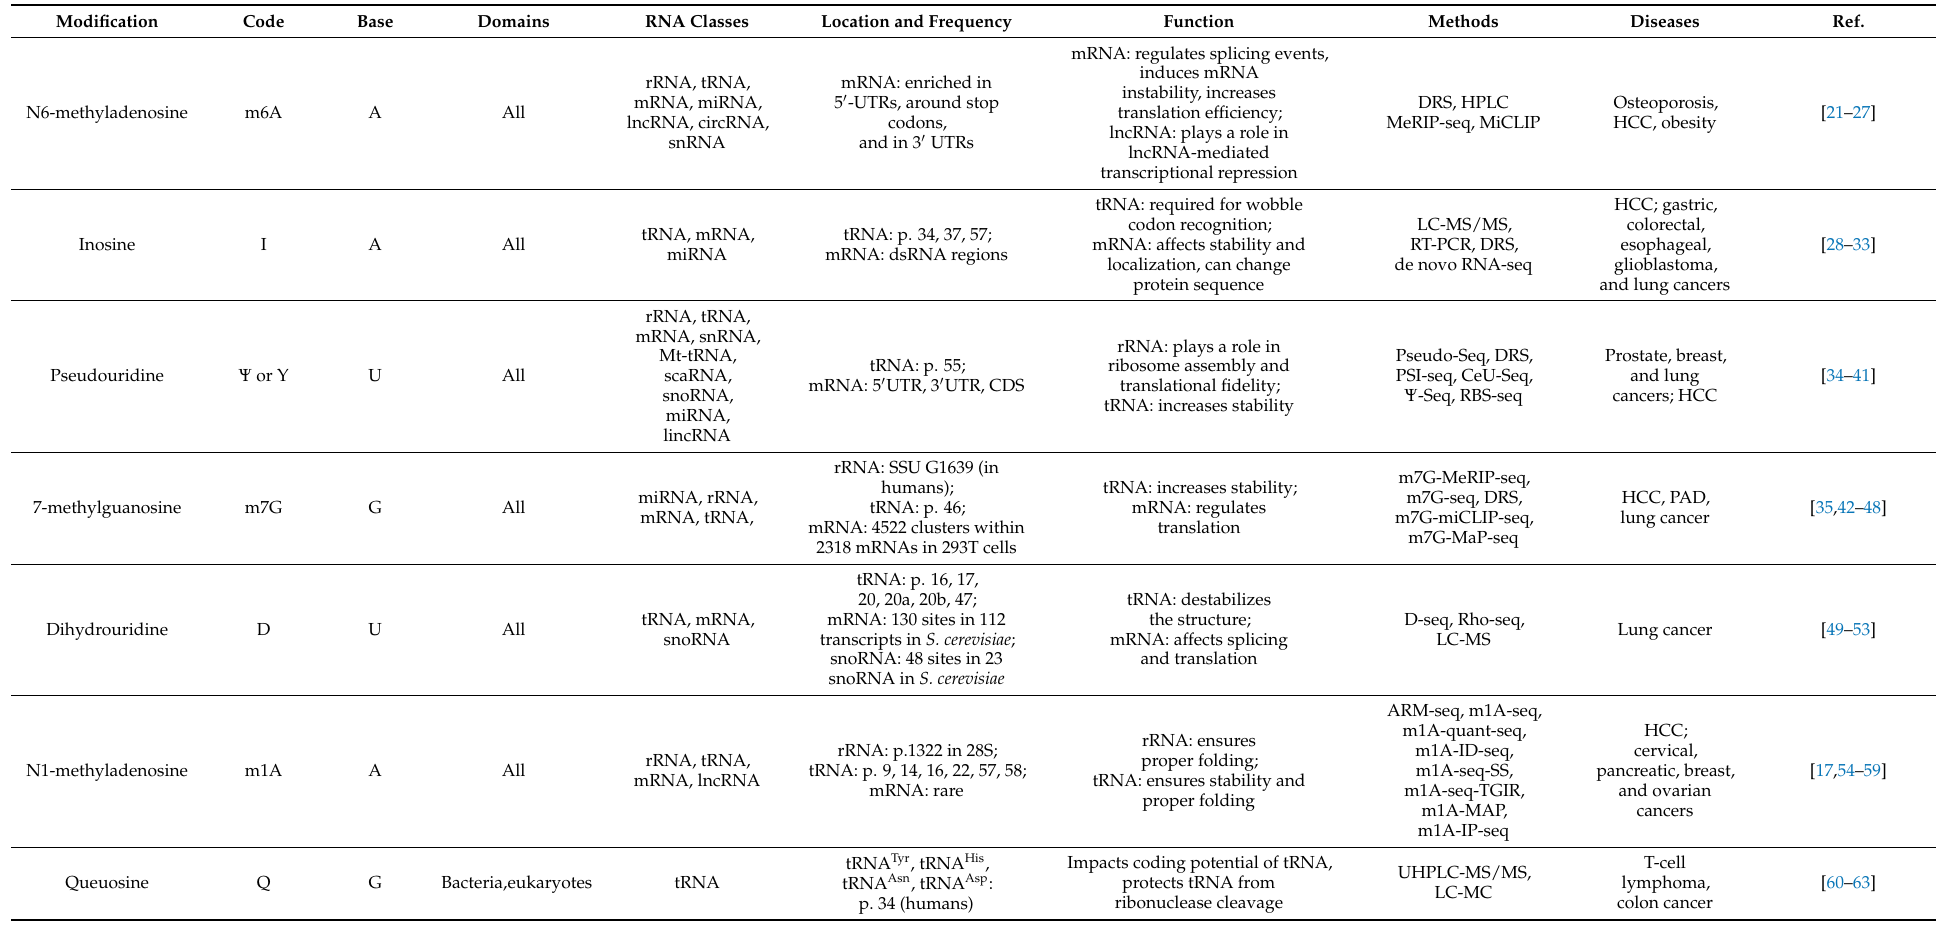
Table 1. Available information on selected RNA modifications; the table is filtered by the frequency of occurrence of modifications in